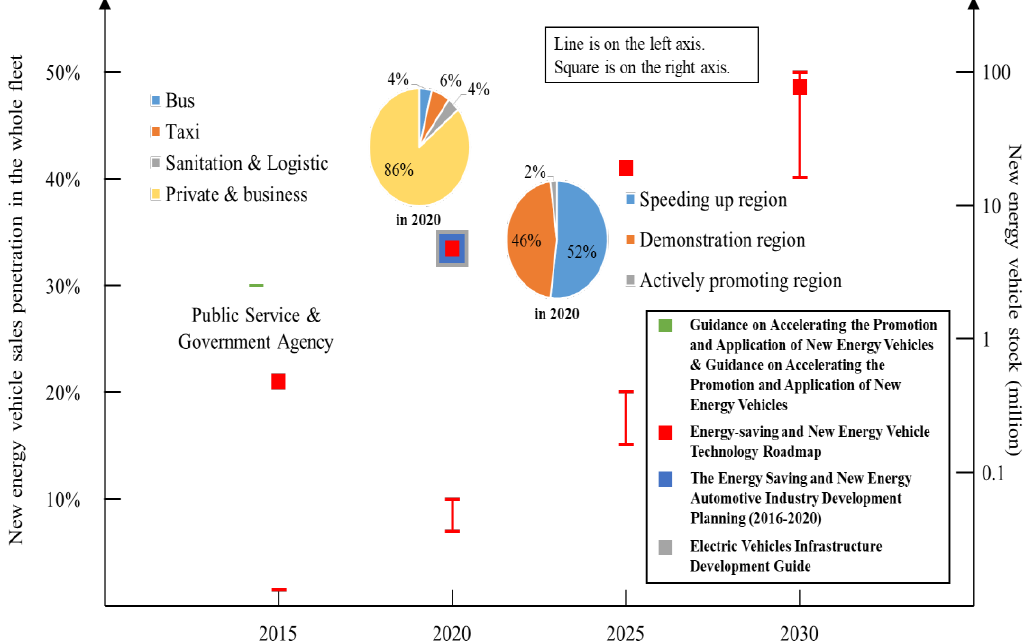
Figure 1. Summary of state EV development plans (the sales penetration of NEV was given in a scope and lines indicates the error bars).